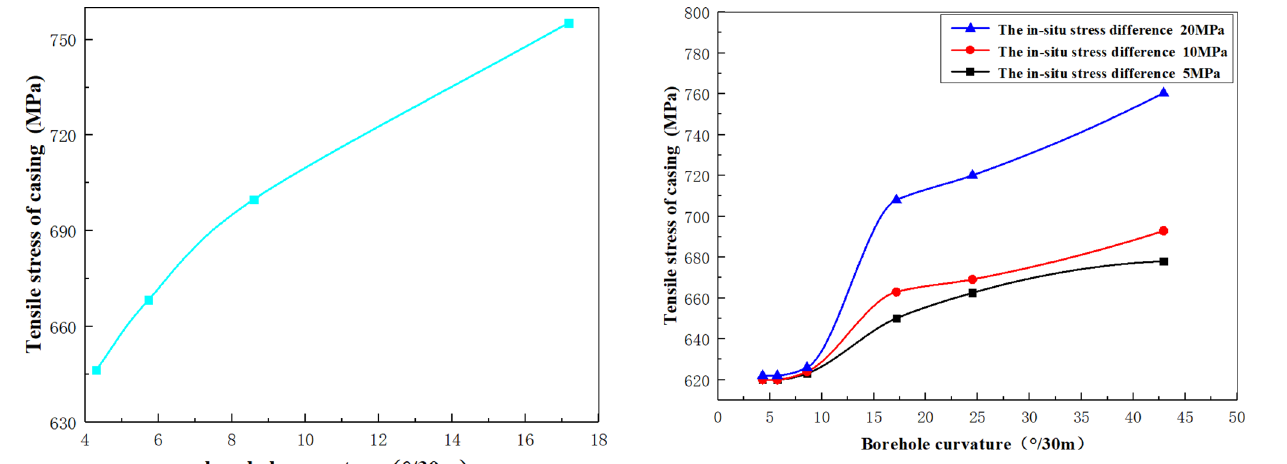
Fig. 5 Casing tensile stress under different borehole curvature